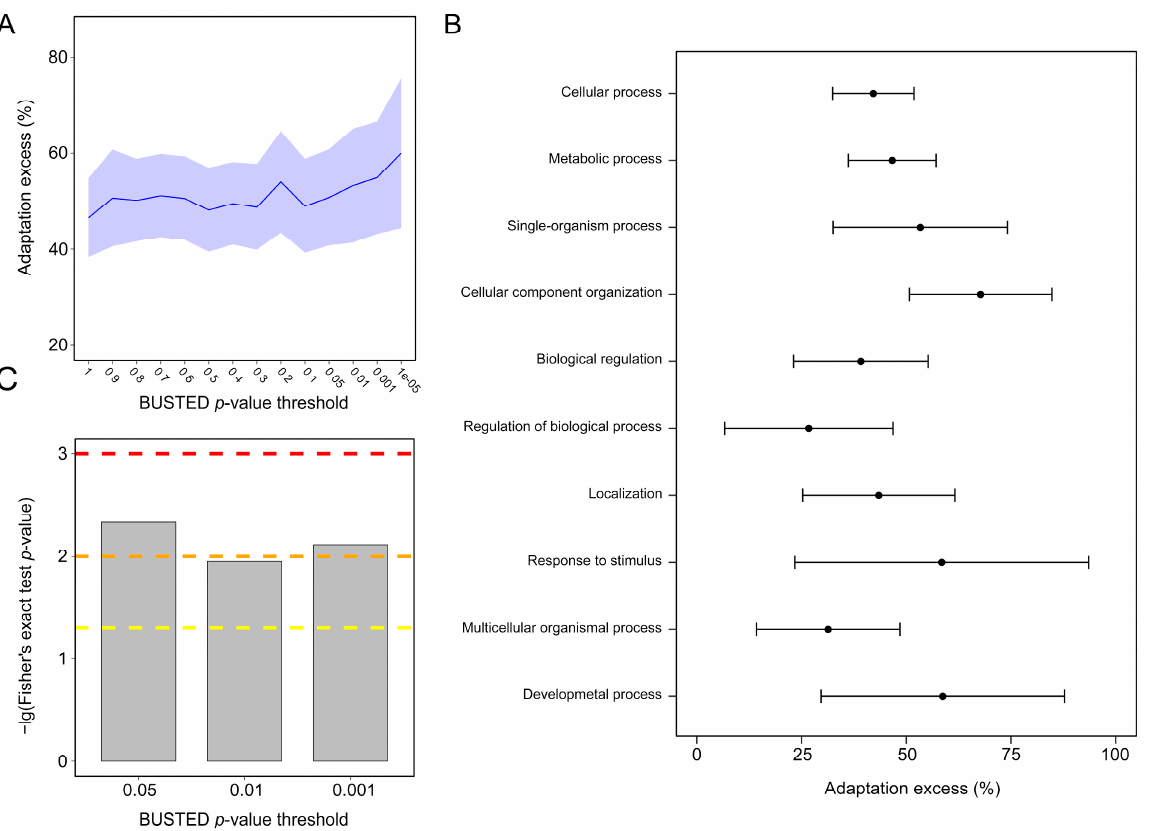
Figure 7. The significant contribution of the nematocyst to cnidarian protein adaptations. ( A ) Excess of adaptation across cnidarians in nematocyst proteins (NEMs). The excess of adaptation is measured as the excess percentage of adaptation in NEMs compared to non-NEMs. The shaded part represents the 95% confidence interval for the excess of adaptation in all NEMs. ( B ) Excess of adaptation within the top 10 high-level GO processes with the most NEMs. Excess is shown for BUSTED p ≤ 0.5. ( C ) The adaptation enrichment in NEMs detected by Fisher’s exact test. Dashed yellow curve, orange curve, and red curve: Fisher’s exact test p -value thresholds of 0.05, 0.01, and 0.001.